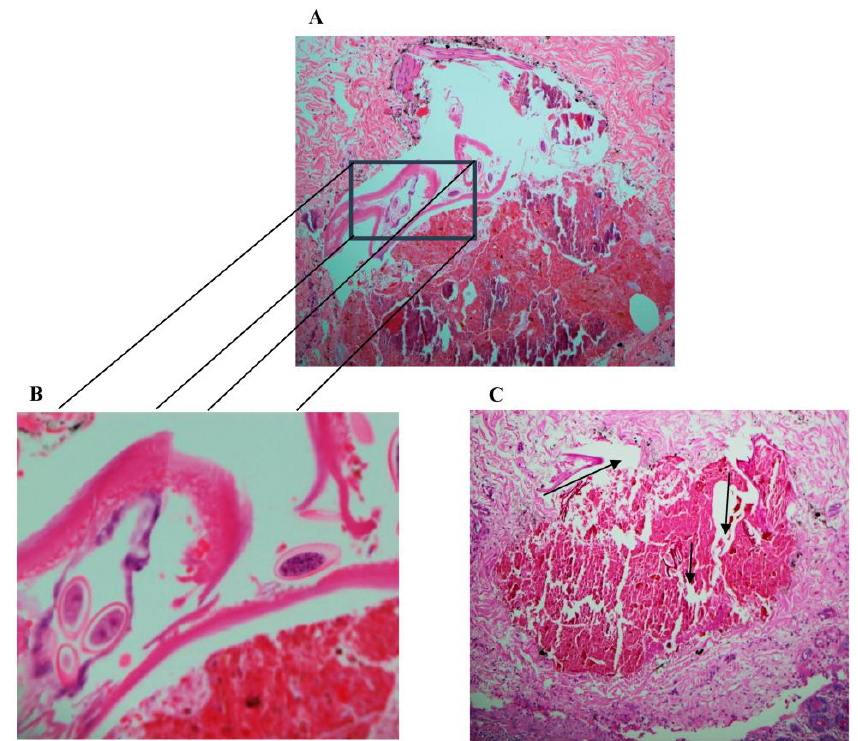
Figure 2. ( A ) Periodic acid–Schiff (PAS), magnification 40×. ( B ) Hematoxylin and eosin stain (H&E), magnification 400×, of Enterobius vermicularis worms with eggs. ( C ) Periodic acid–Schiff (PAS), magnification 200×, showing worm embedded in the muscle wall with surrounding necrosis (arrows).